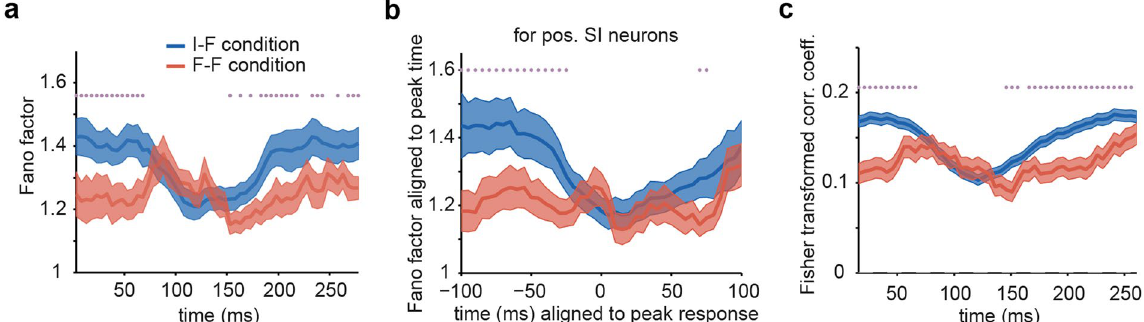
Figure 4. Variability of spiking activity and correlation of neuronal responses under the I-F and F-F conditions. ( a ) The time courses of the Fano factor across all neurons. The Fano factor at each time point was computed by the slope of the regression line between the mean and variance of response across all neurons. The stars show significant differences between two conditions, which were assessed by a one-tailed z-test. ( b ) The Fano factor of pos. SI neurons aligned to the peak time of neuronal responses. The responses of the neurons were aligned to the peak time of their differential response, and the mean-matched Fano factor was calculated similarly to that shown in ( a ). ( c ) The time-course of correlation between simultaneously recorded pairs of neurons, which was calculated using z-scored responses. To avoid state-dependent correlations, z-scoring was performed based on neighboring trials. The stars show the significance of differences between two conditions (paired t-test, p < 0.05). In all graphs, blue and red curves indicate the non-adaptation (I-F) and adaptation (F-F) conditions, respectively. Shaded areas represent